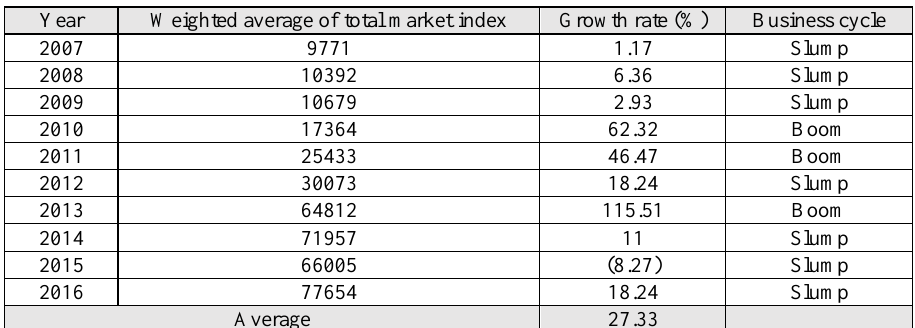
Table 1: Classification of research period